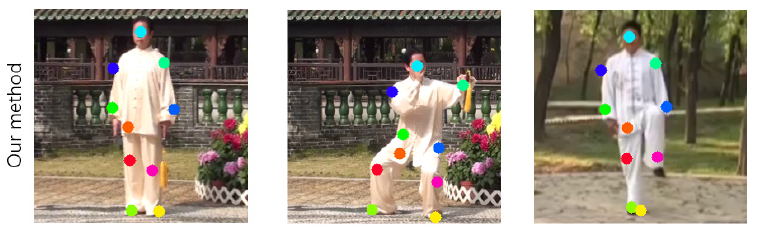
Figure 13. Our method and FOMM’s visualization of keypoints in the TaiChiHD dataset. (The different colorful dots represent different key points, and the red circles indicate the incorrect key points.)